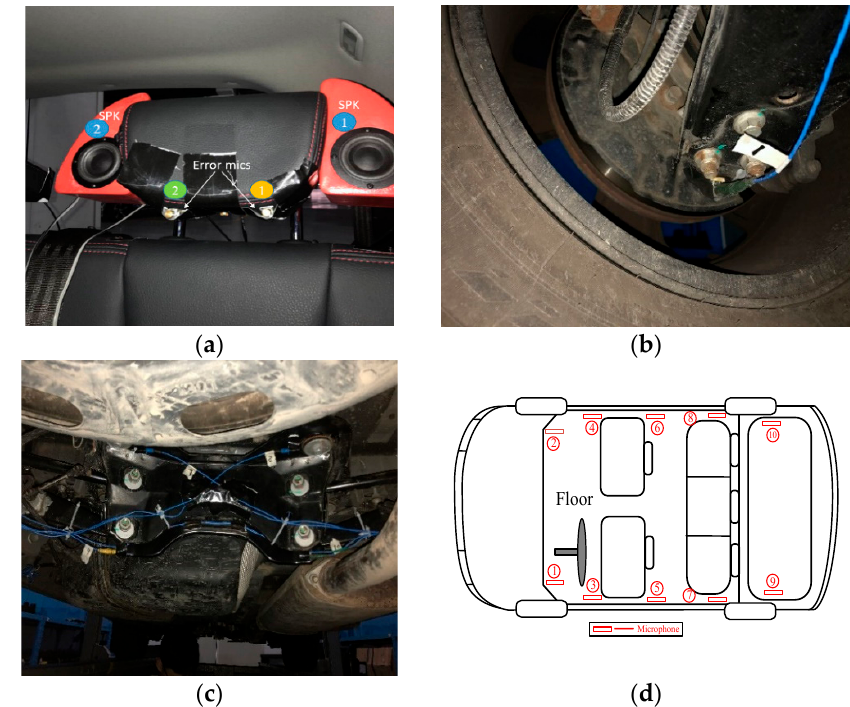
Figure 2. ( a ) The active headrest system at the rear left seat of the SUV containing two headrest speakers and two error microphones; ( b ) The installation location of accelerometer: the hubs of axle; ( c ) A few installation locations of accelerometers: the bushings of sub-frame, the joints between bodywork and sub-frame; ( d ) The schematic diagram of the numbered reference microphone placement.